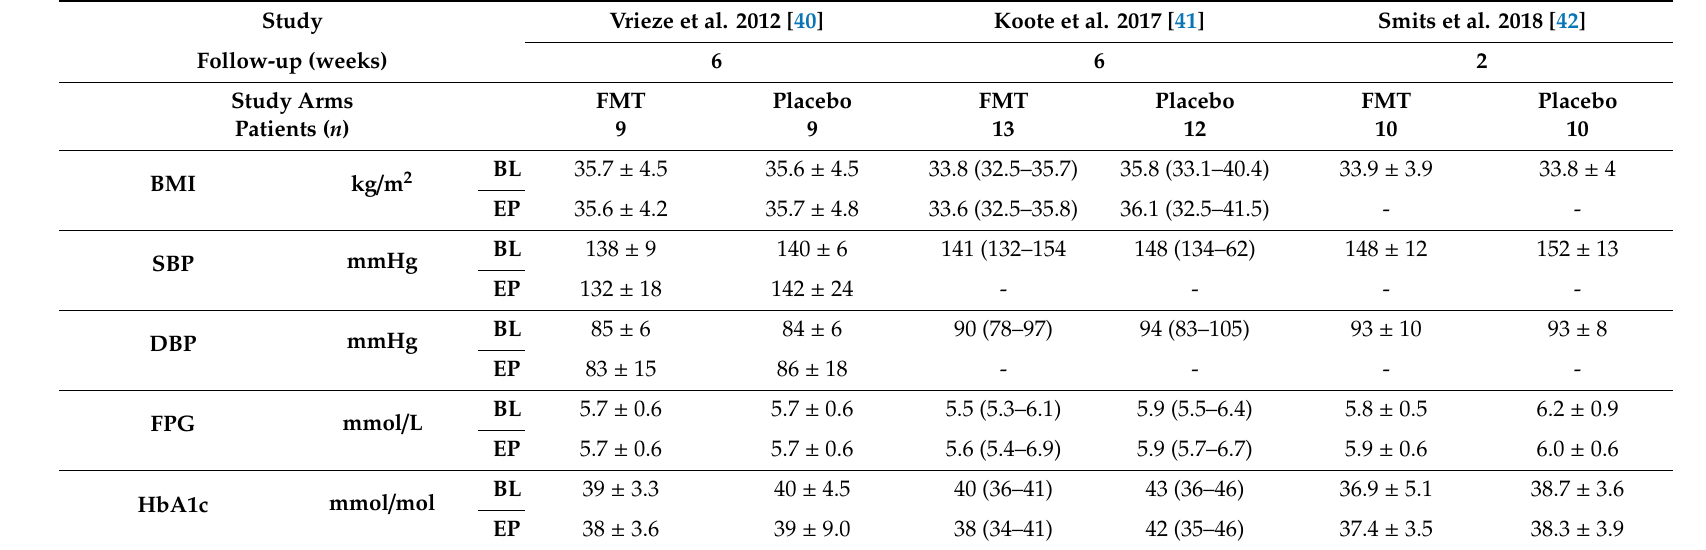
Table 2. Metabolic parameters of included